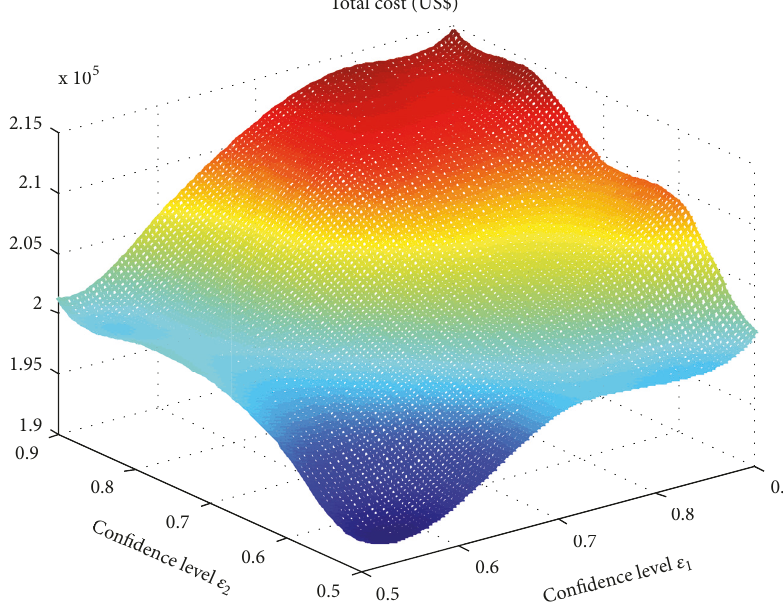
Figure 8: The total cost with different confidence